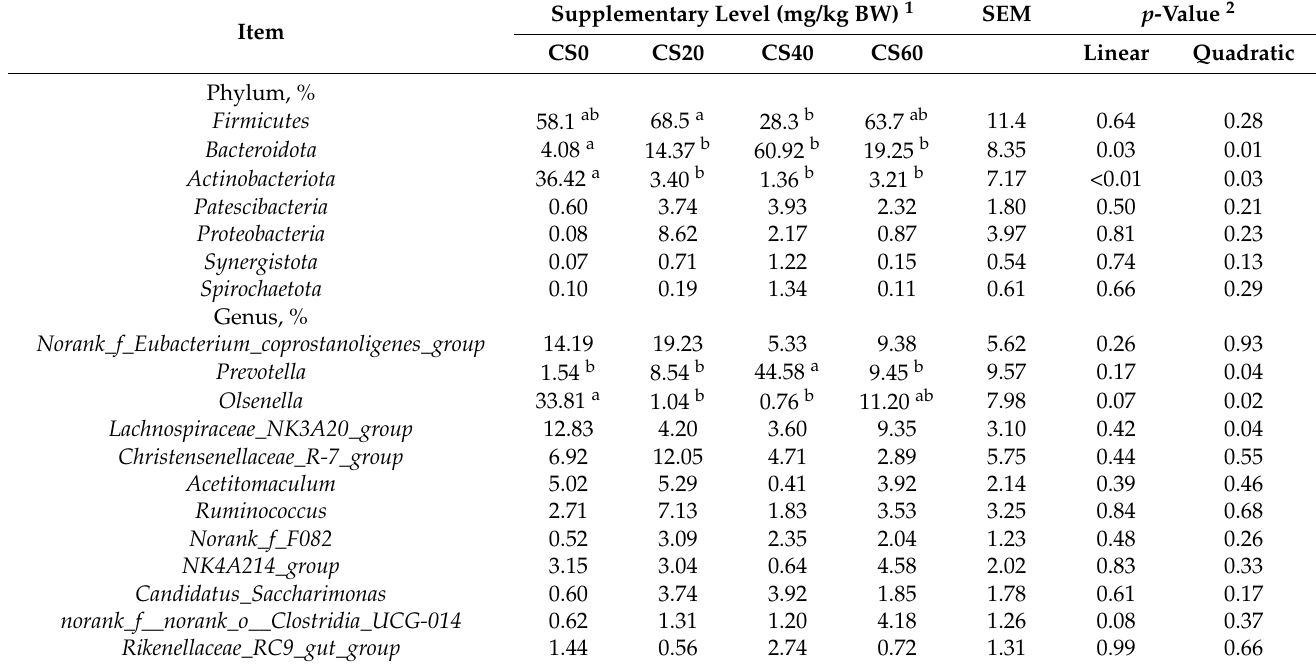
Table 6. Microbial community analysis at the phylum level (relative abundance > 1%) and genus level (relative abundance > 5%) of microbiomes obtained from rumen fluids of